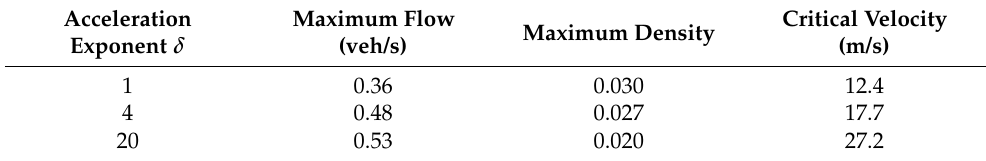
Table 3. Maximum flow, maximum density, and critical velocity for the ID